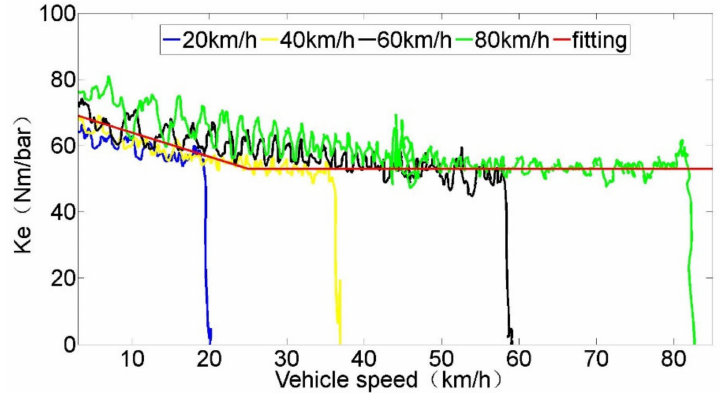
Figure 12. Evolution of K e under different initial vehicle